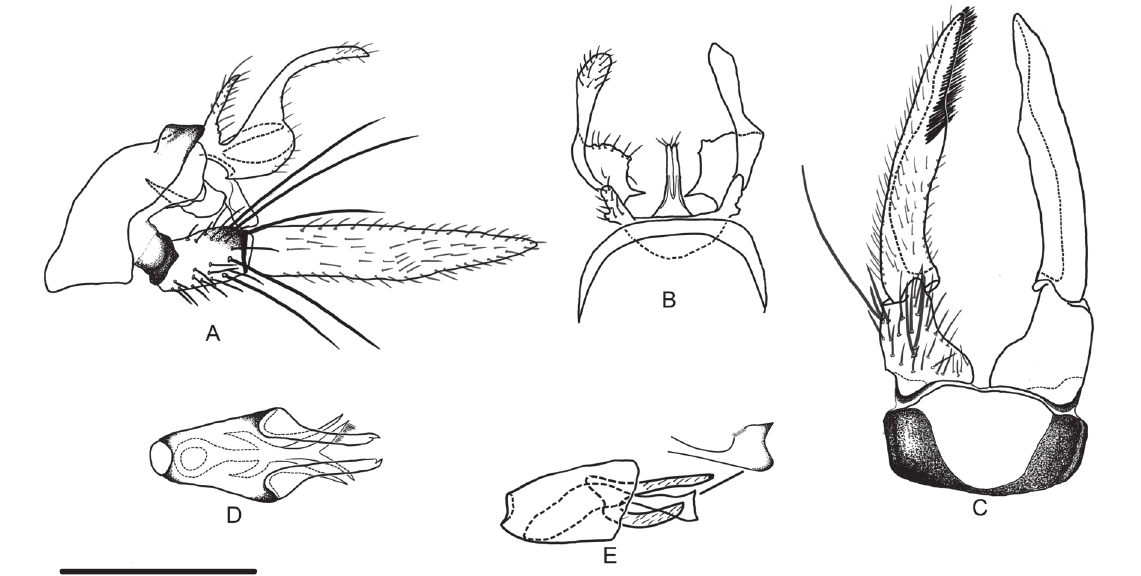
Fig. 6. Male genitalia of Apatidelia acuminata Leng & Yang, 1998. A . Lateral view. B . Dorsal view. C . Ventral view. Aedeagus. D . Dorsal view. E . Lateral view. Scale bar = 0.5 mm refers to all